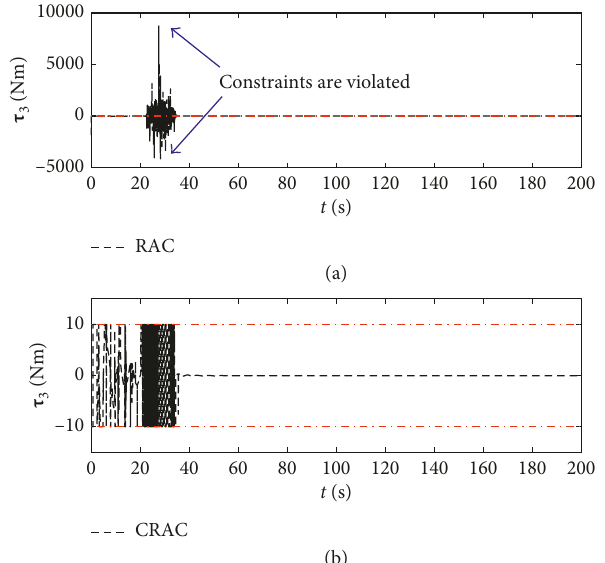
Figure 20: Time response of output control torque τ